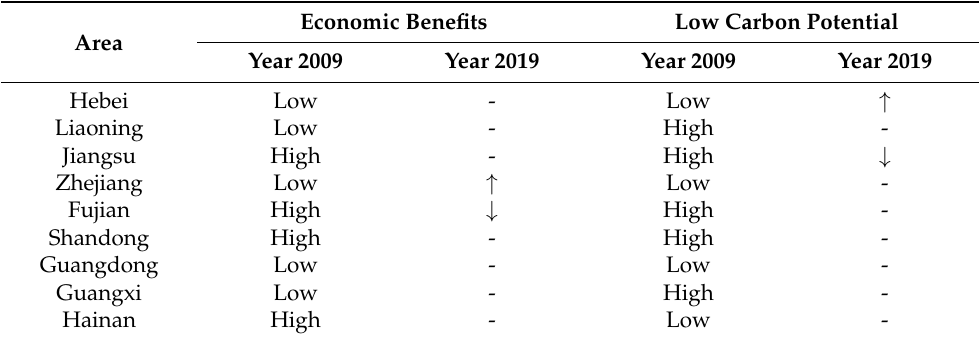
Table 13. Analysis of the economic benefits of marine fishery carbon emissions and the development potential of low-carbon fisheries in nine coastal